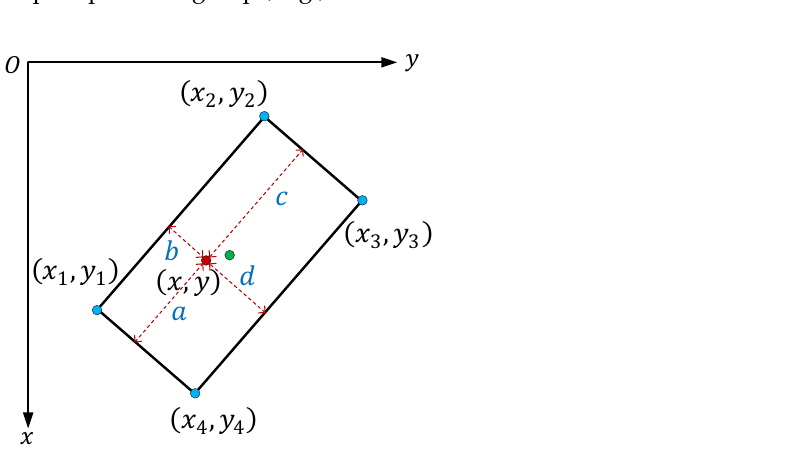
Figure 5. Illustration of the oriented center-ness. The four blue dots, red dots, and green dots denote the corner points of an oriented bounding box, the feature map point ( x , y ) , and the center point of the oriented bounding box,